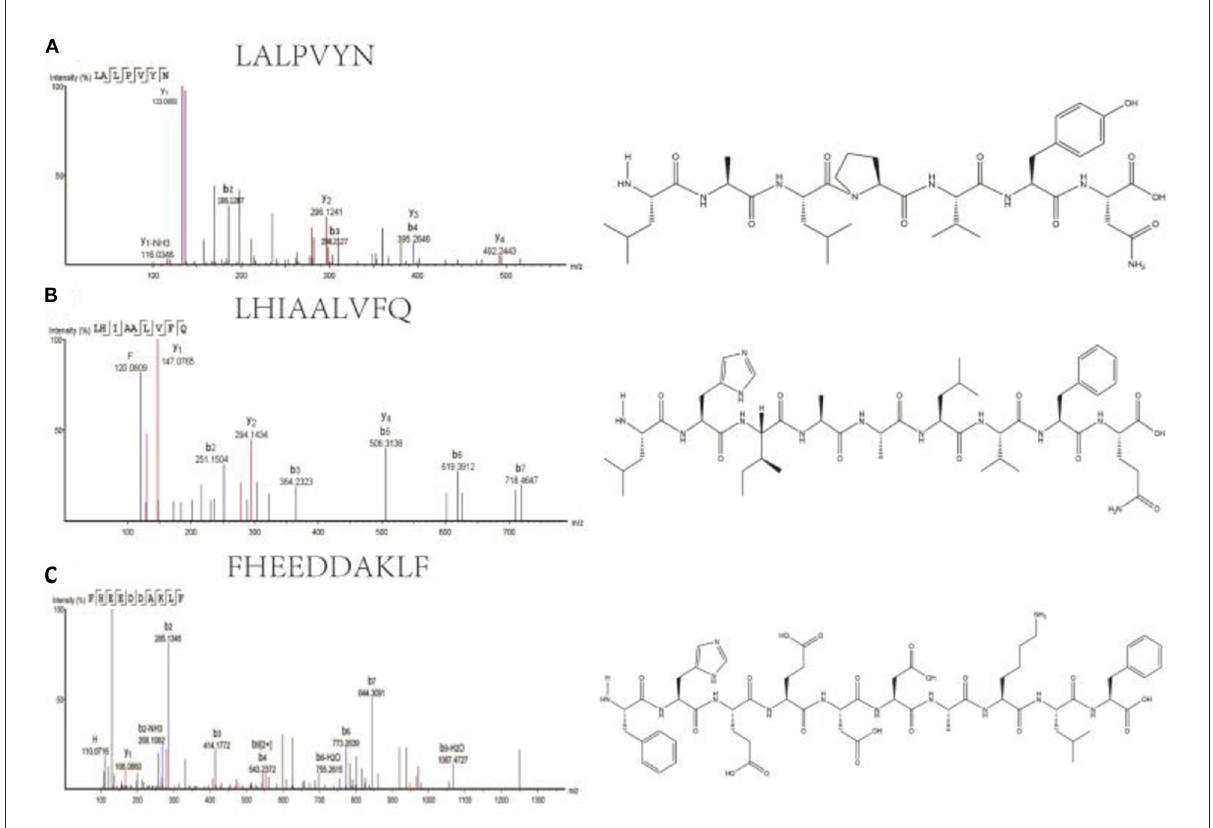
FIGURE2 Secondary mass spectra and chemical structures of LALPVYN (A) , LHIAALVFQ (B) , and FHEEDDAKLF (C) .